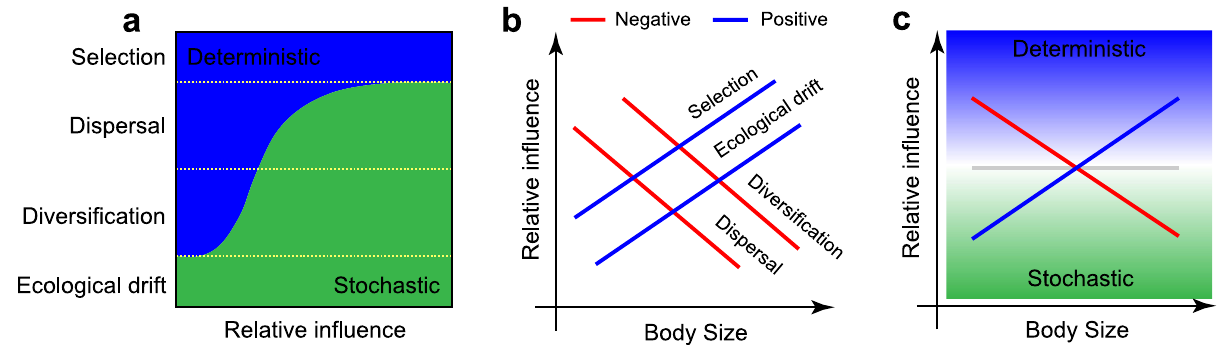
Fig. 1 The conceptual framework for the study. Conceptual model displaying ( a ) the extent at which the four classes of ecological processes (selection, dispersal, ecological drift, and diversi fi cation; sensu Vellend 12 ) relates to the stochastic-deterministic balance. Here, selection is an exclusively deterministic process, whereas drift is exclusively stochastic. Dispersal and diversi fi cation are partially stochastic and partially deterministic. This occurs because both dispersal and diversi fi cation rates can be in fl uenced by deterministic organism ’ s life-history traits (e.g., spore-forming organisms and horizontal gene transfer, respectively), as well as by random factors (e.g., passive dispersal and mutation); b a hypothetical visualization of the relative in fl uence of each process according to distinct organism body sizes. Selection and ecological drift are more prone to in fl uence organisms with bigger body sizes due to their relatively lower population sizes. On the other hand, diversi fi cation and dispersal is conceptualized to exert a higher in fl uence on organisms with smaller body sizes. Despite selection and ecological drift opposition in the stochastic-deterministic spectrum (plot a), we hypothesized that c the effect of selection might override that of ecological drift in organisms with bigger body sizes, thus resulting in a greater deterministic signal. Conversely, we conceptualize that random dispersal can have an overriding effect on the assembly of organisms with smaller body sizes, thus resulting in a greater stochastic